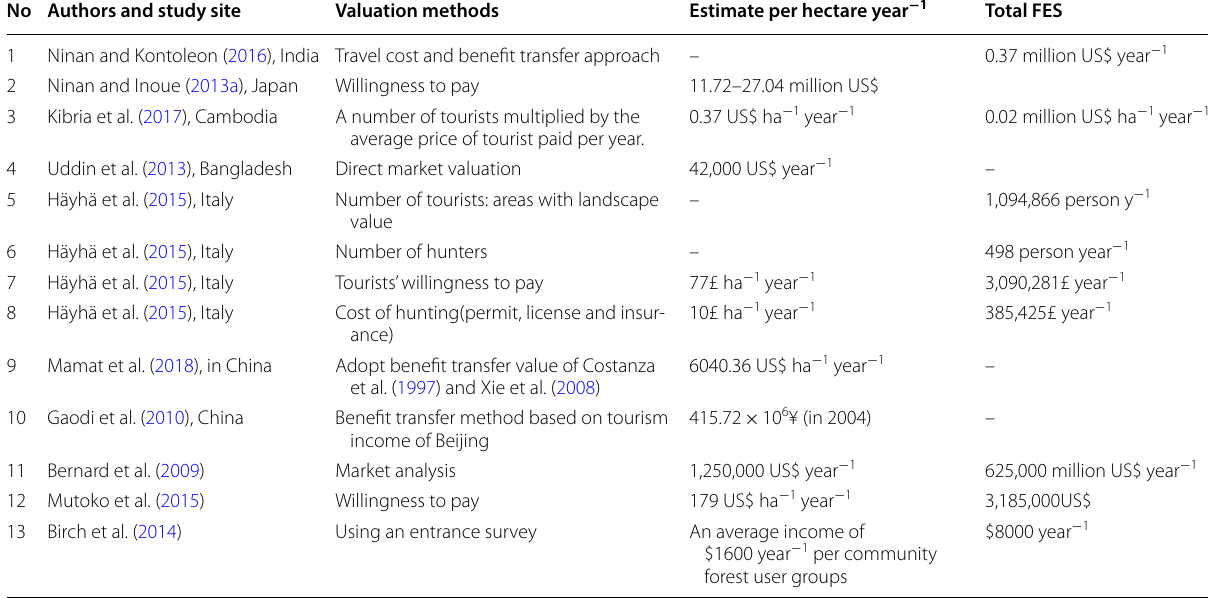
Table 8 Reviewed studies dealing with recreation including its methodology and monetary